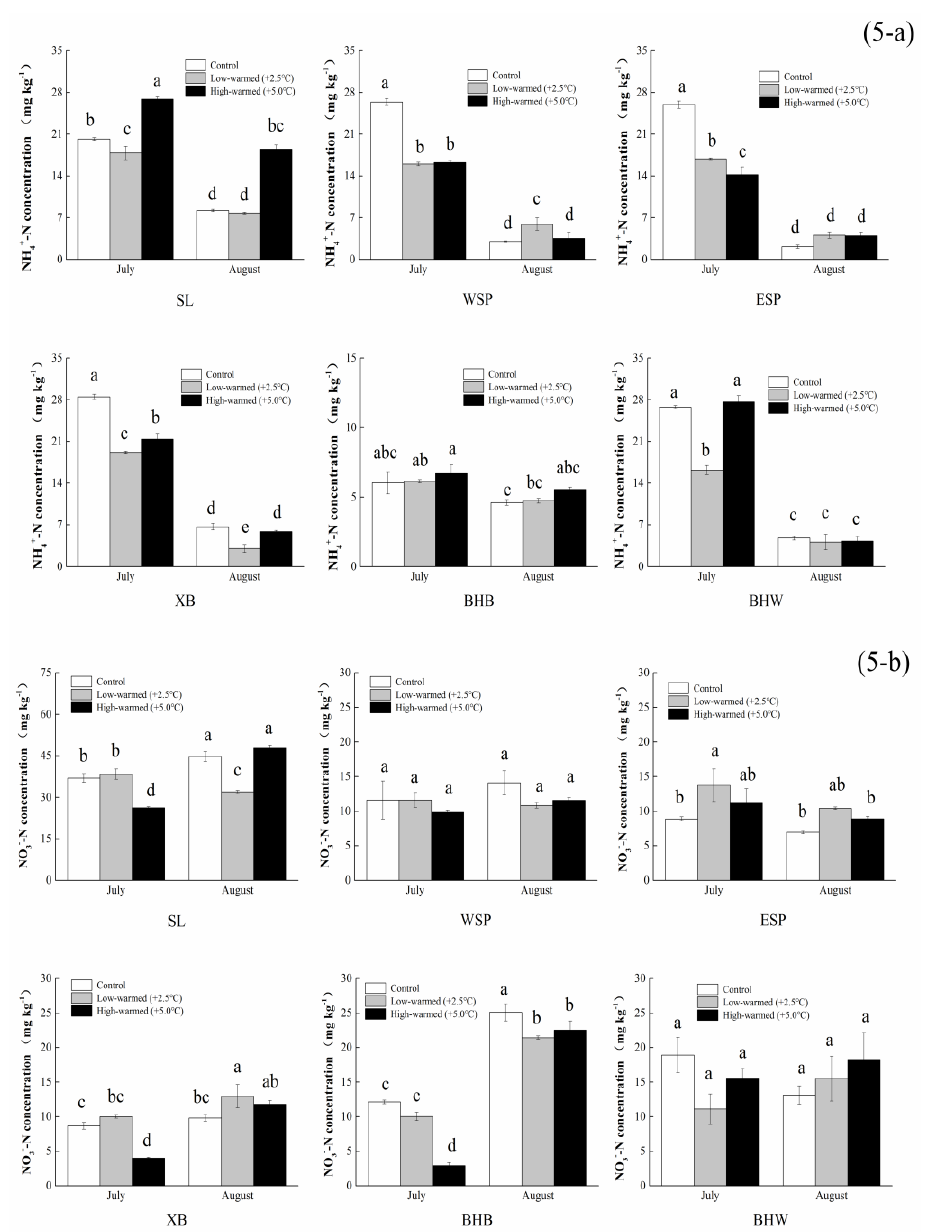
Figure 5. Statistical differences of NH 4+ -N (5- a ) and NO 3 − -N (5- b ) in sediments collected from wetland pillars in the temperature simulation experiment (control: ambient temperature; low-warmed: ambient temperature +2.5 ◦ C; high-warmed: ambient temperature +5.0 ◦ C). The abbreviation of wetland sampling sites is identified on the x -axis and the NH 4+ -N and NO 3 − -N concentrations in the sediments are identified on the y -axis. Error bars represent the standard error of the mean of three parallel samples. Means with the same small letters (a, b, c, d) are not significantly different at p = 0.05.